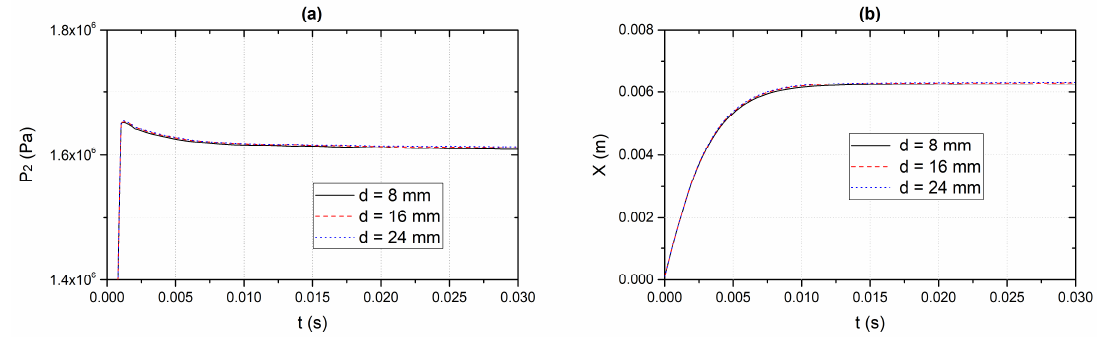
Figure 9. Effect of varying the diameter of the valve stem ( 𝑑 = 8, 16, and 24 mm) on the valve start-up characteristics under 𝑞 (cid:3032) = 8 L/s and 𝑃 (cid:2869) = 1.6 MPa: ( a ) Outlet pressure 𝑃 (cid:2870) ; ( b ) poppet displacement 𝑋 . characteristics under q e = 8 L / s and P 1 = 1.6 MPa: ( a ) Outlet pressure P 2 ; ( b ) poppet displacement X